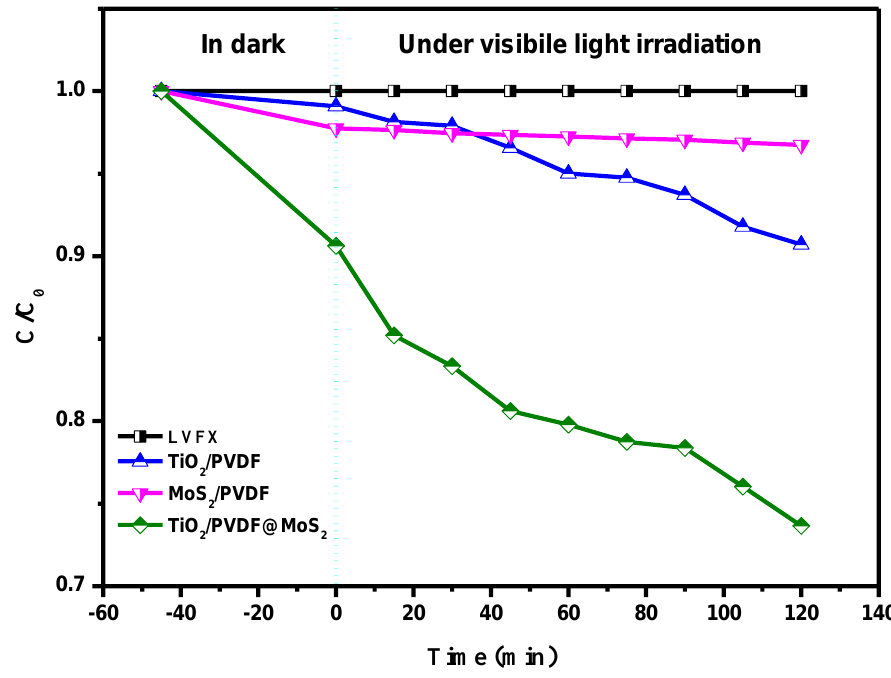
Figure 10. Photocatalytic degradation curves of LVFX over the samples: LVFX without photocatalyst, TiO 2 /PVDF, MoS 2 /PVDF and TiO 2 /PVDF@MoS 2 .